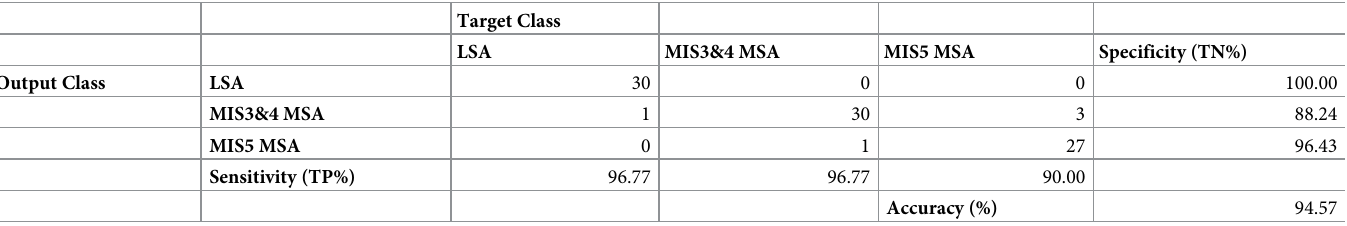
Confusion table for the overall classifications produced by the ensemble of 1,000 networks in the 3-way analysis. TP% = percentage of true positives. TN% = percentage of true